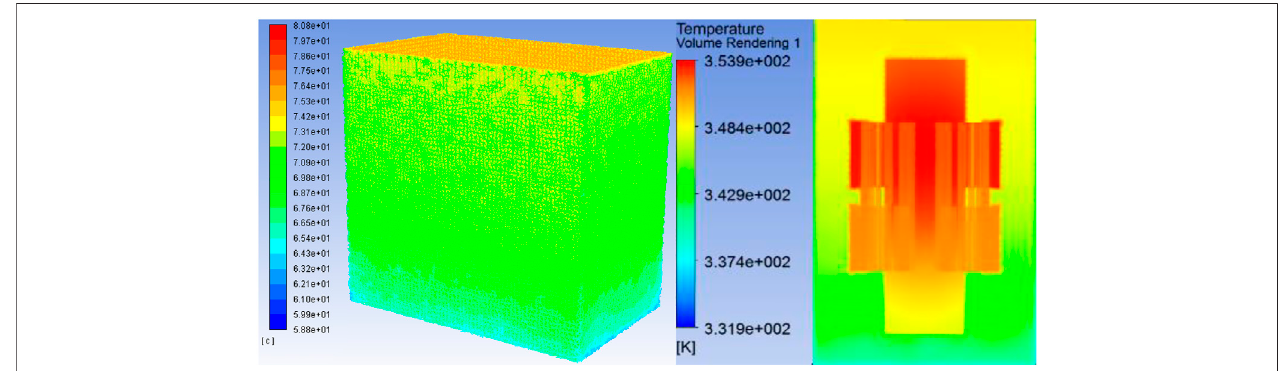
FIGURE 14 | Transformer temperature fi eld (insulating oil vibration model).